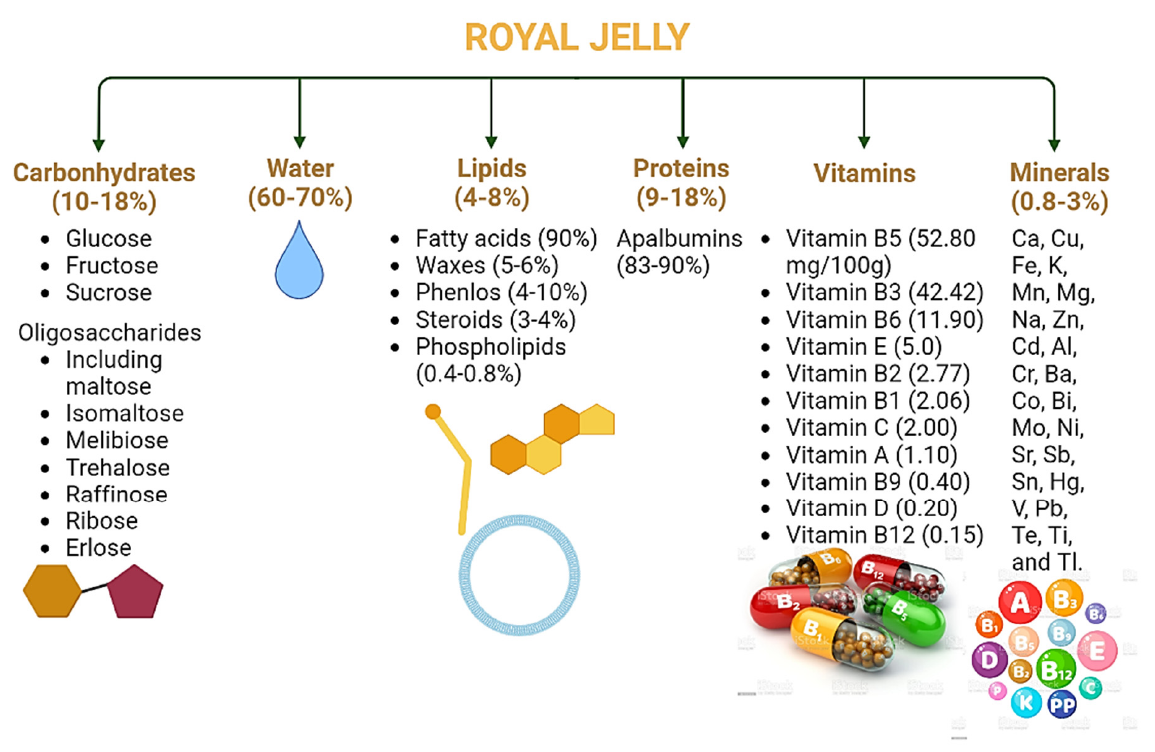
Figure 7. General composition of royal jelly.